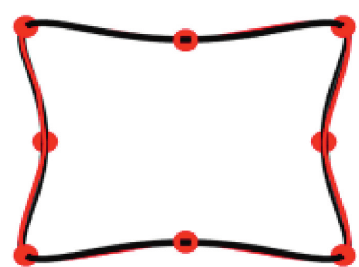
Figure 17: Best optimal curve achieved.